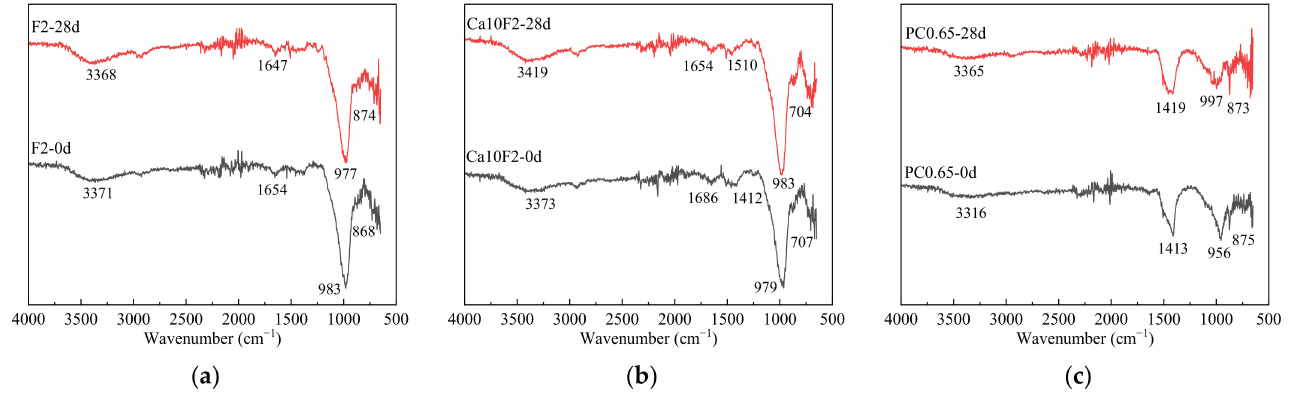
Figure 9. FT-IR images of geopolymers and cement before and after carbonization. ( a ) F2; ( b ) Ca10F2; ( c )